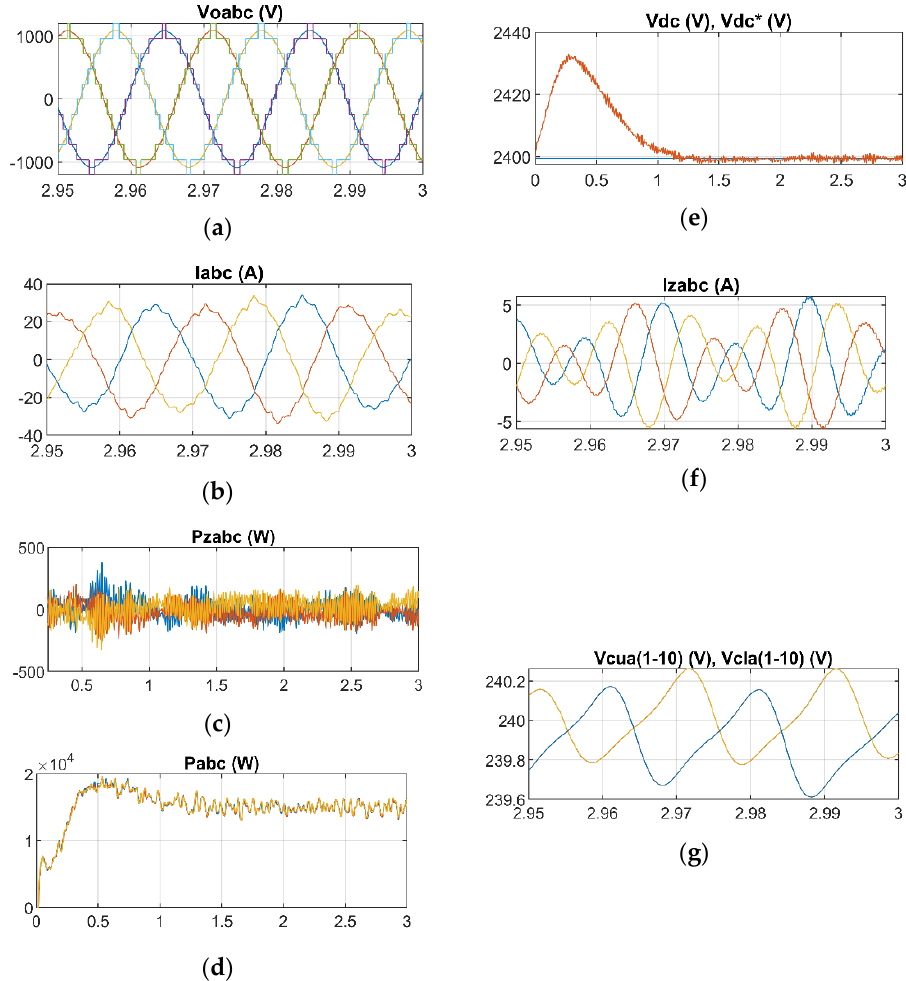
Figure 7. Simulation graphs when the power is medium and the generation is balanced. ( a ) Output voltages. ( b ) Output currents. ( c ) Power transferred between phases. ( d ) Power delivered by each phase. ( e ) Voltage on the DC link. ( f ) Circulating currents. ( g ) Capacitor voltages. Table 5. Summary of the peak values of the variables obtained in the simulation. Voltages are in volts, currents in amperes, and angles in degrees. All variables are 50 Hz except where noted. Sub-